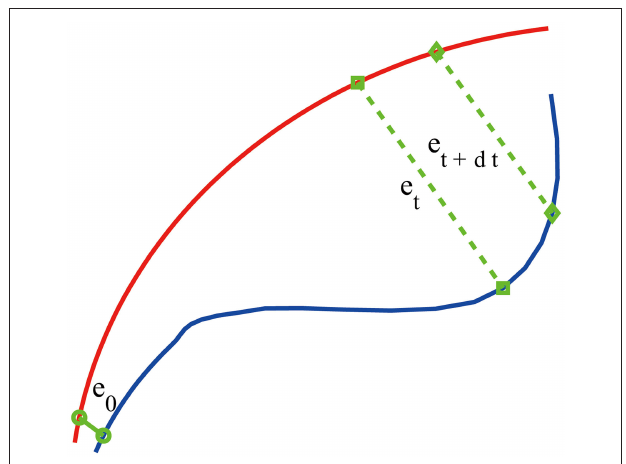
FIGURE 2 | A schematic showing two arbitrary trajectories in a general high-dimensional space, with the distance between them at time 0, t , and t δ t being ǫ 0 , ǫ t , and ǫ t , + + δ t